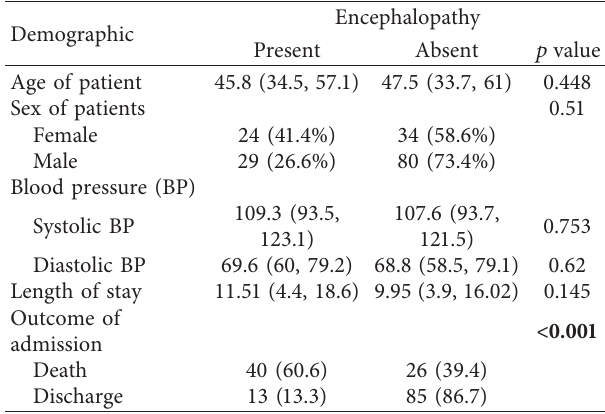
Table 4: Precipitating factors for hepatic encephalopathy.